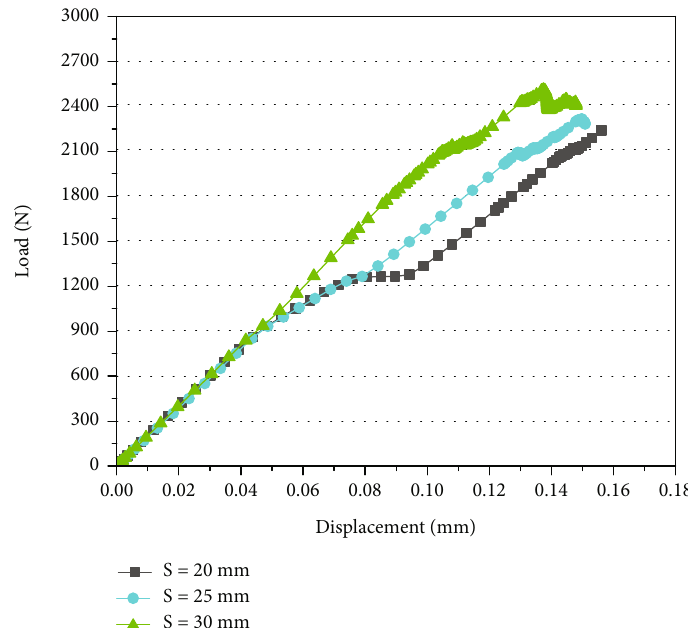
Figure 13: Load – displacement relationships for the C/SiC composite and superalloy double bolted joints under various levels of double-bolt center spacing at 750 ° C.